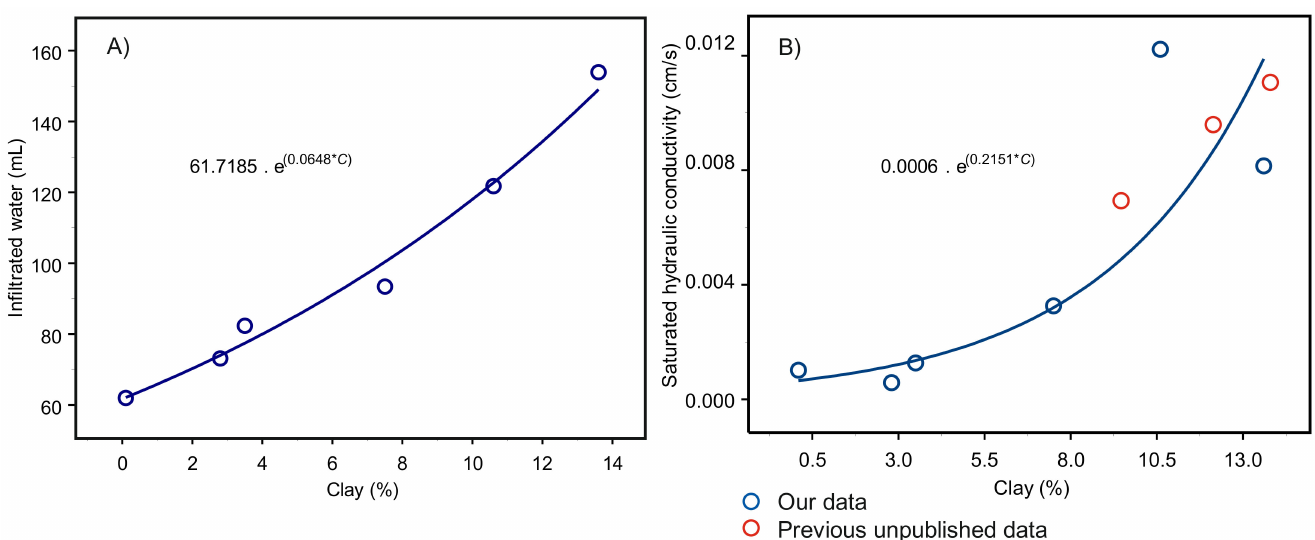
Figure 2. Laboratory investigations on six reconstructed mineral soils: ( A ) exponential relationship between clay content C and infiltrated water; ( B ) exponential relationship between clay content C and saturated hydraulic conductivity K s